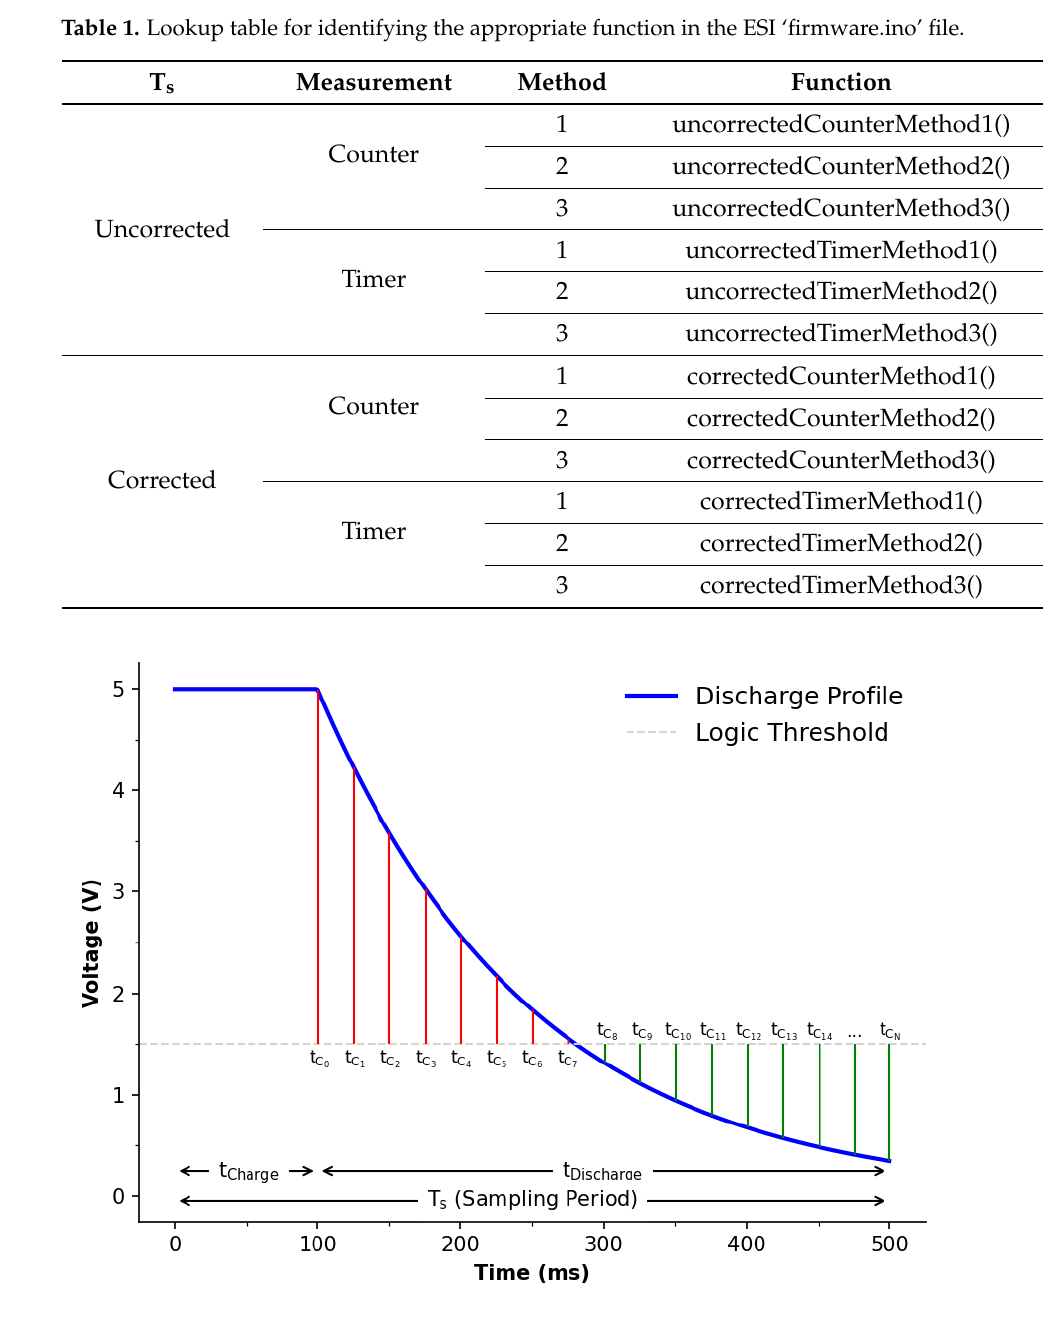
Figure 2. LED voltage model showing a charge and discharge profile for explanatory